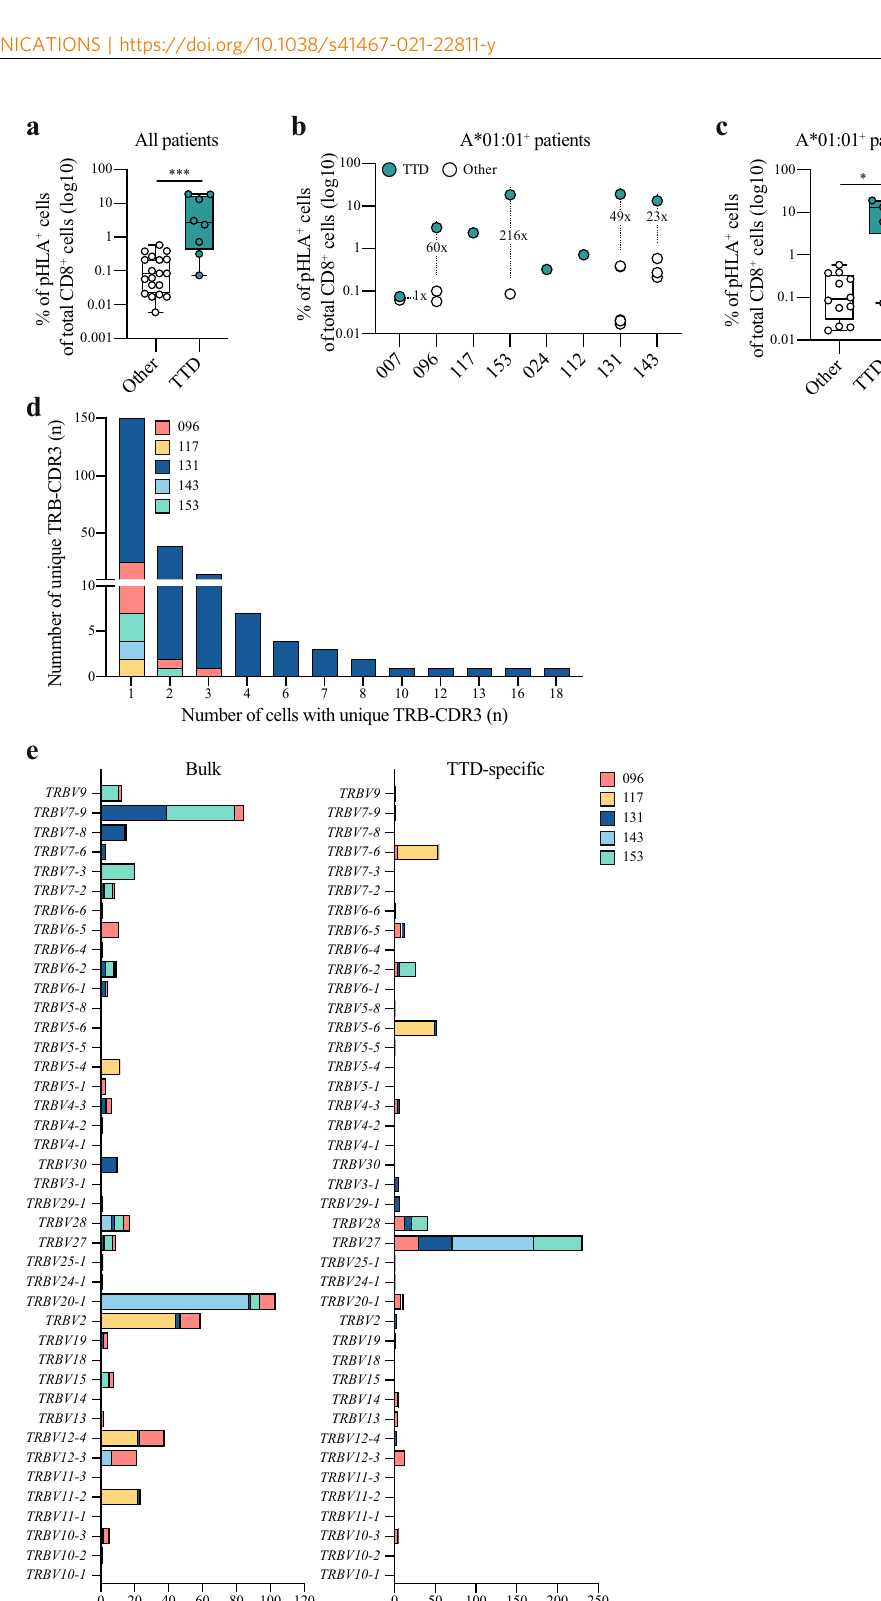
CD8 T cell responses that were detected in 5 COVID-19 patients with acute COVID-19 disease. The TTD-speci fi c CD8 T cell responses were found to have no (4 patients) or very low levels of cytokine production (1 patient) after 12 h of stimulation (Fig. 3a, b and Supplementary Fig. 3a – c). From one patient, suf fi cient cell numbers were available to include a cytomegalovirus